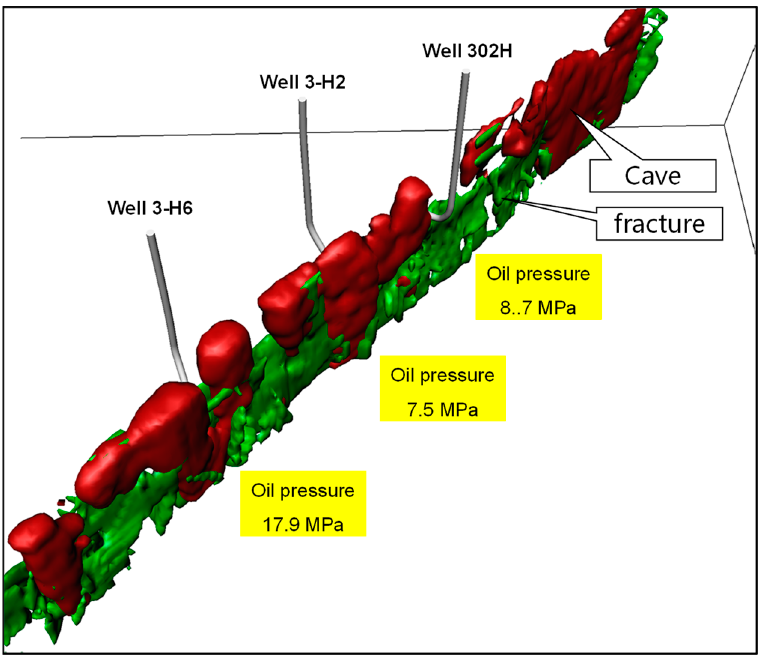
Figure 9. 3D fracture-cave reservoir model showing the reservoir connectivity in well M1 area (the green blocks showing fracture network, the red blocks showing cave reservoirs). green blocks showing fracture network, the red blocks showing cave